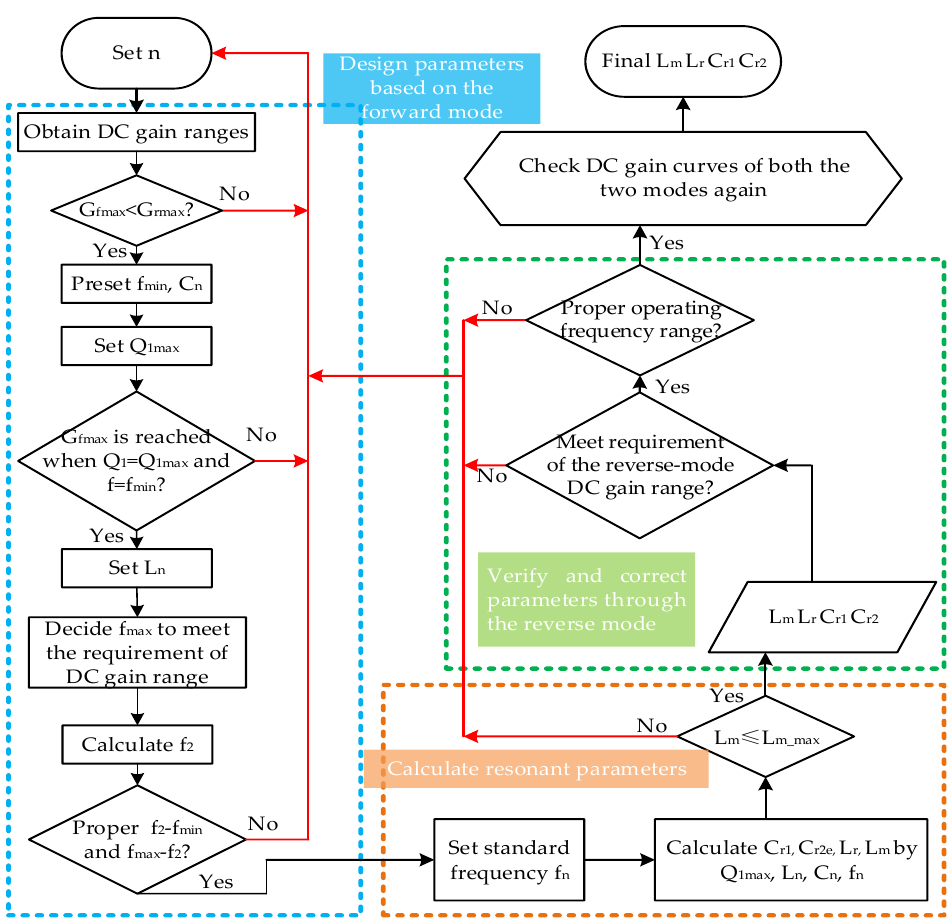
Figure 6. Flow chart of designing GaN-based CLLC-BRC.